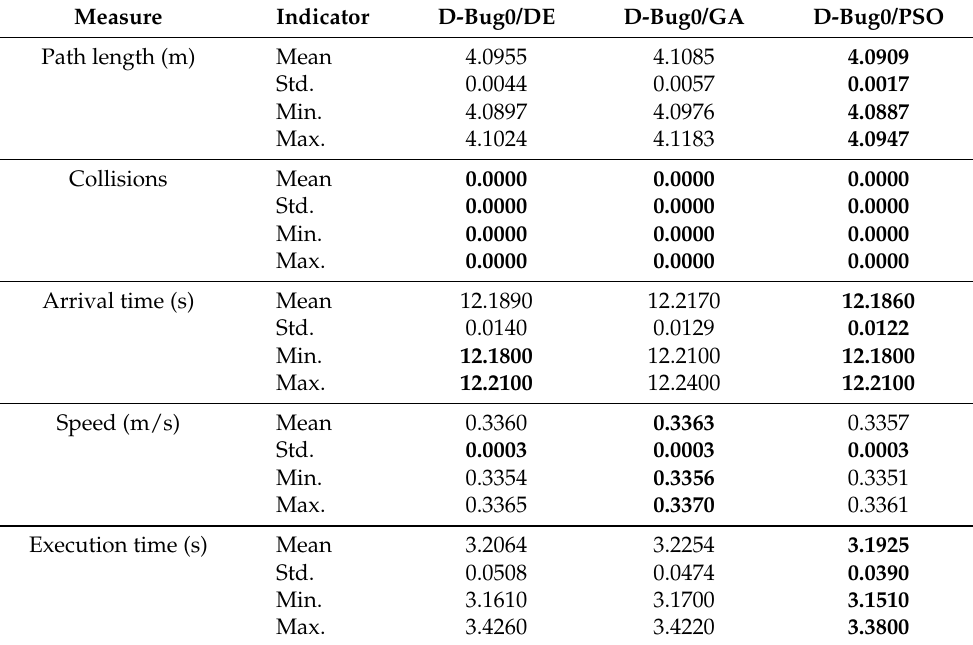
table, the small value of the standard deviation, compared to the mean, for all indicators, indicates that the results obtained are very similar in each run, highlighting the reliability of D-Bug0. Table 2. Descriptive statistics on the results of the 30 independent executions with D-Bug0/DE, D-Bug0/GA, and D-Bug0/PSO. Measure